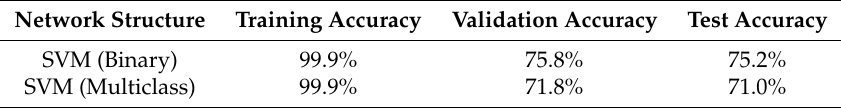
Figure 9. Support vector machine (SVM) test performances: ( a ) the ROC curve of the binary classifier, ( b ) The confusion matrix of the multiclass classifier. Table 2. The accuracy performances of SVM based